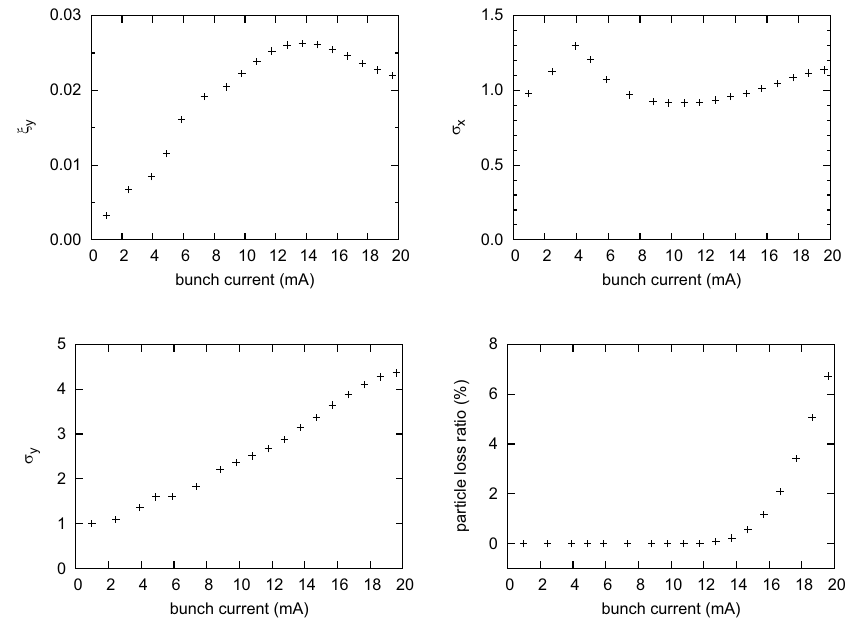
(cid:3) (cid:7) (cid:1) 0 : 53 ; 0 : 58 (cid:3) . The size is ; 7 x y